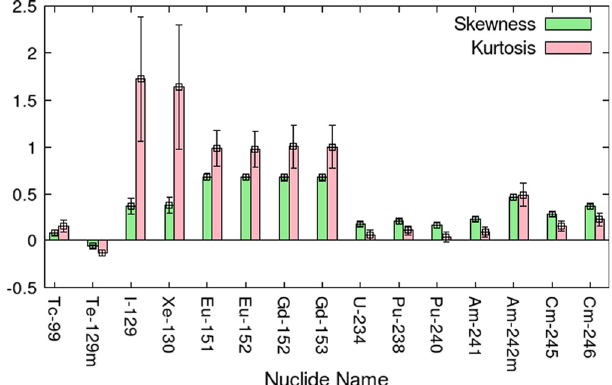
Fig. 1. Example of distorted probability density distribution.